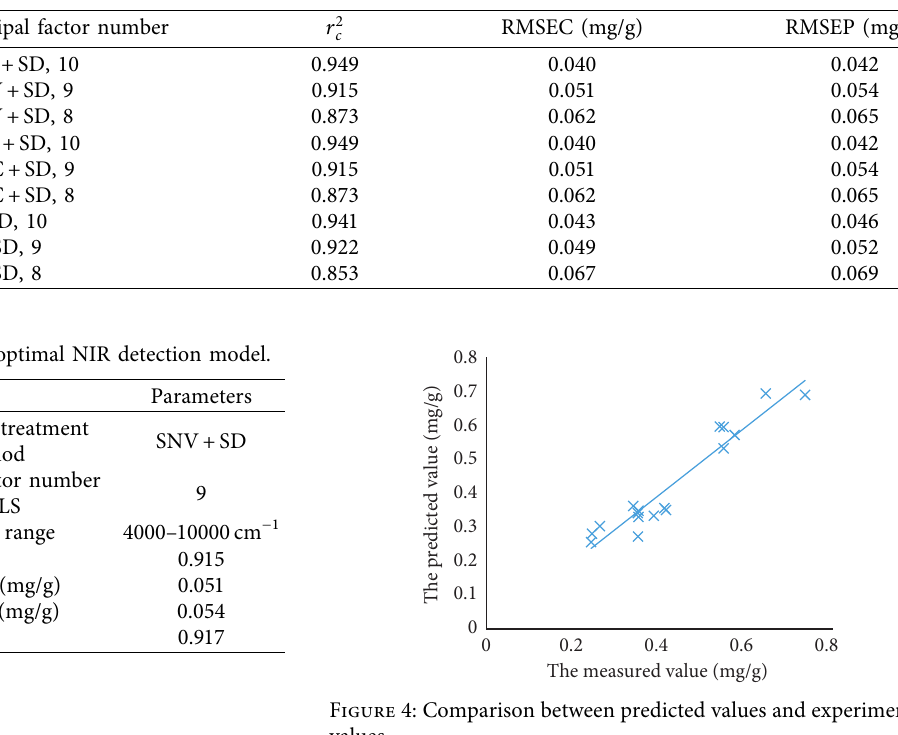
Table 5: The test results for the number of principal components.